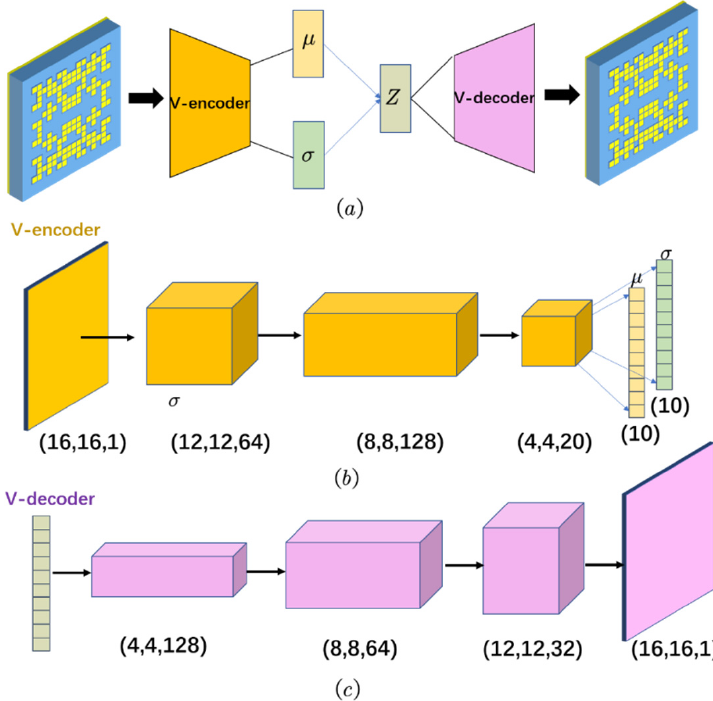
Figure 6. ( a ) The structure of variational autoencoder. ( b ) The internal structure of V-encoder. ( c ) The internal structure of V-decoder.